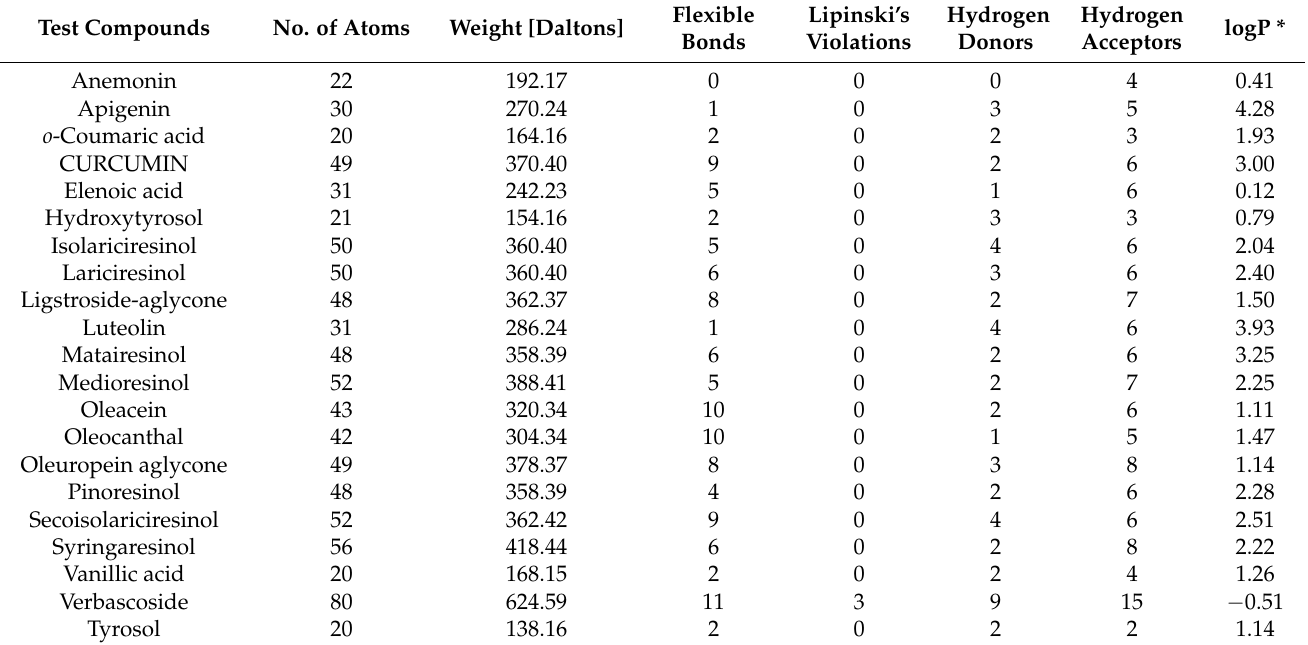
Table 2. Predicted drug-likeness parameters for the 20 + 1 natural compounds found in human diet (alphabetic